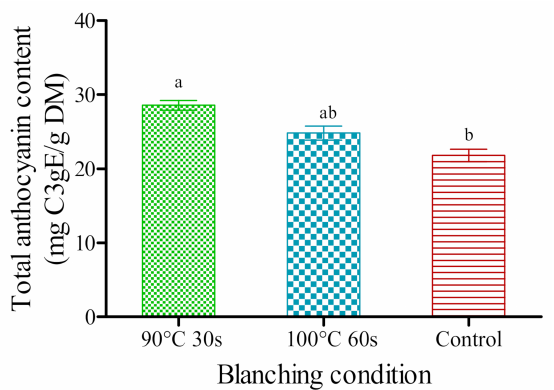
Figure 4. Total anthocyanin content in dried pomegranate arils cv. Wonderful at different blanching conditions. (Data presented as means ± SE. Bars followed by different letter(s) are significantly different ( p < 0.05) according to Fisher’s